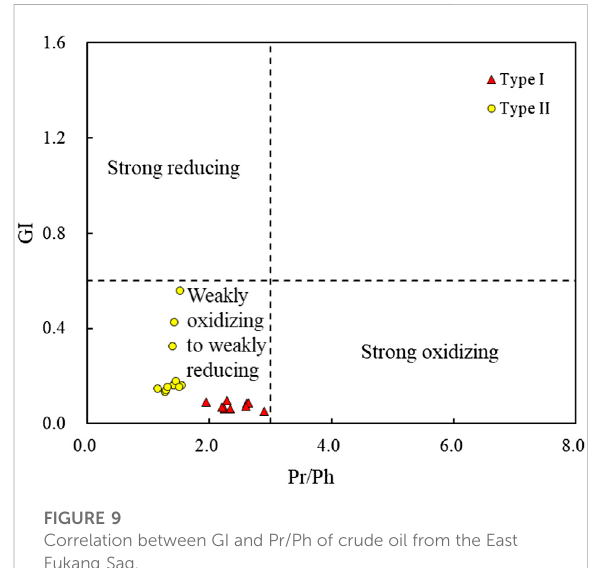
FIGURE 9 Correlation between GI and Pr/Ph of crude oil from the East Fukang